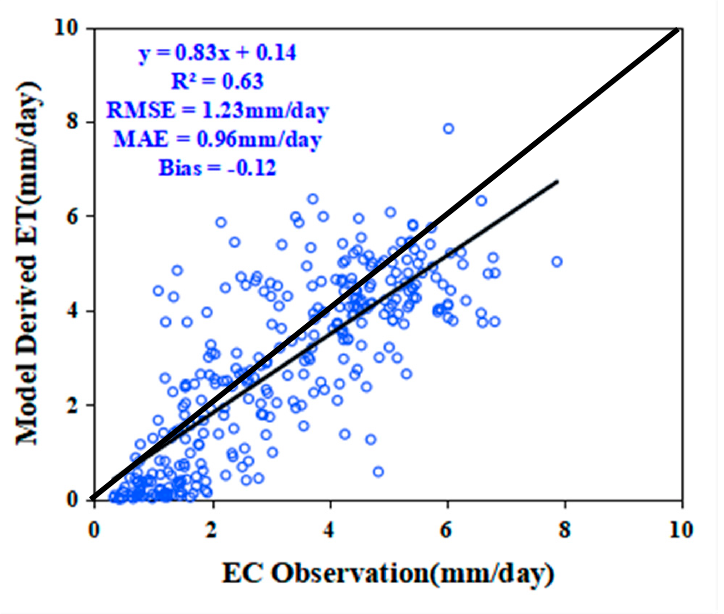
Figure 11. Scatters of the ET estimates of model derived by the reconstructed LST against in situ measurements, where ET: evapotranspiration.